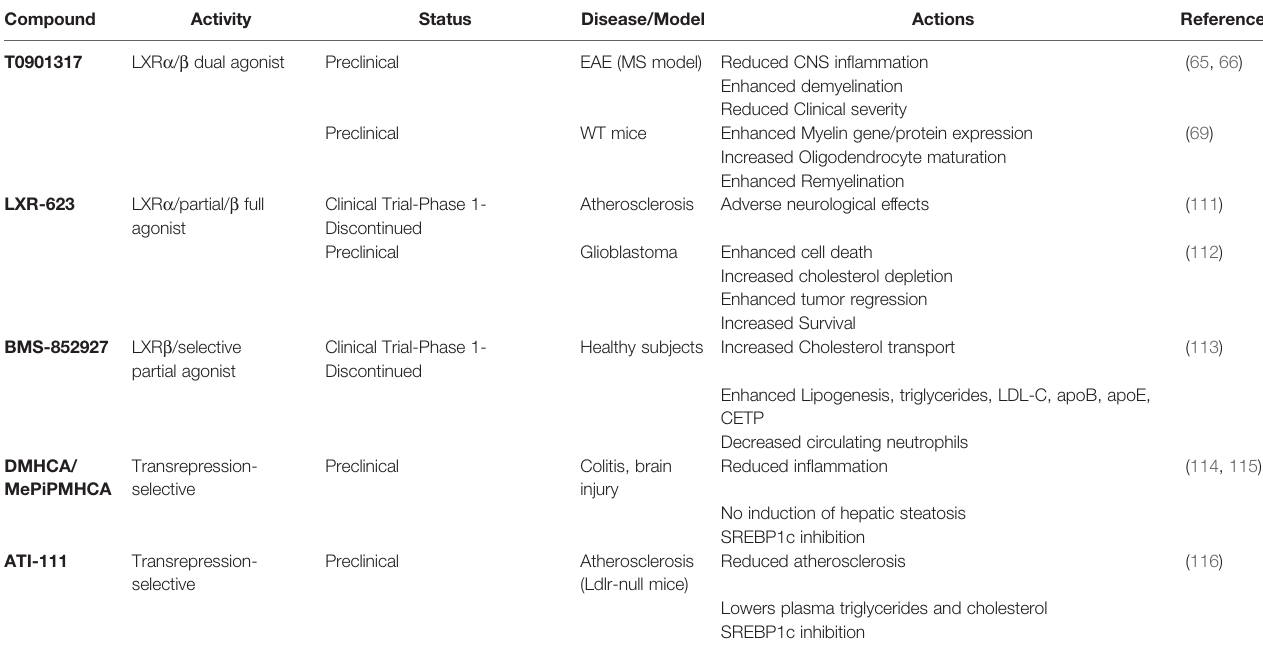
TABLE 1 | Summary of synthetic LXR agonist